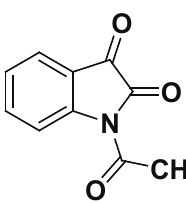
Figure1 : Chemical structure of 1-acetyl-1 H -indole-2,3-dione ( N